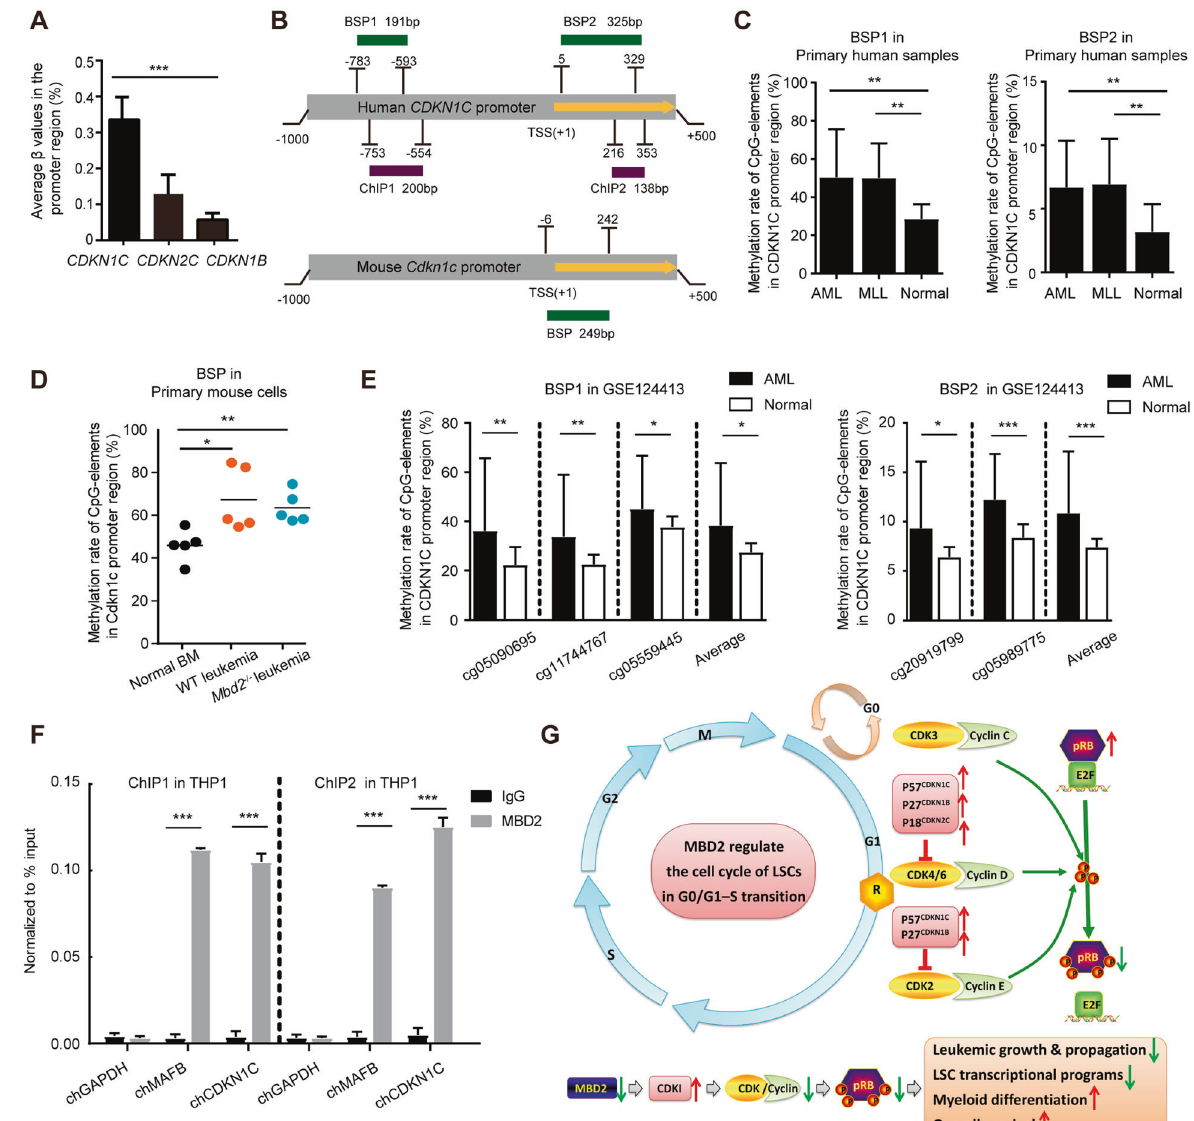
Fig. 6 MBD2 may suppress the transcriptional expression of CDKN1C by binding to its promoter in leukemic cells. A Average β values of CDKN1B (P27), CDKN1C (P57), and CDKN2C (P18) in AML patients from the TCGA dataset. Error bars, s.d. B Schematic representation of the CDKN1C promoter in humans and mouse, respectively. Short horizontal lines represent corresponding positions ampli fi ed by bisulphite sequencing PCR (BSP) and chromatin immunoprecipitation (ChIP) primers. Upper panel, the human CDKN1C promoter region. Lower panel, the mouse Cdkn1c promoter region. TSS, transcription start site as + 1 position. C The CDKN1C methylation levels for the location of the CpG islands (BSP1 and BSP2 regions) in normal human BM cells ( n = 11), AML patients ( n = 19), and MLL patients ( n = 9) are shown. Error bars,